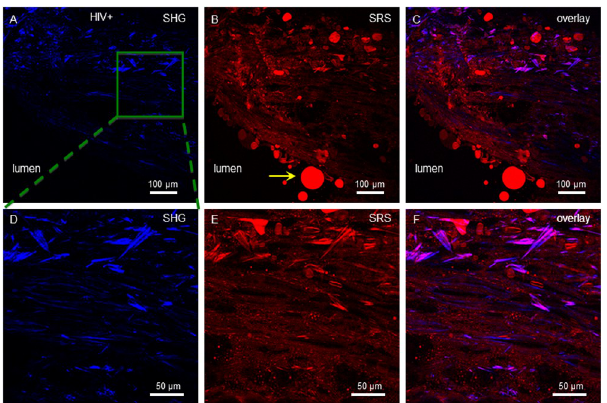
Fig 6. Lipid rich plaque from HIV + coronary artery showing needle CCs. SHG (A), SRS (B) and overlay (C) images of a lipid rich plaque. Panels (D), (E) and (F) show the same plaque at higher magnification, corresponding to the area enclosed by the green box in (A). SRS images were recorded at 2845 cm -1 . Magenta indicates regions of high overlap in the overlay images. Vessel lumen of the left descending artery and magnification scales are indicated, and yellow arrow in panel B indicates fat droplet in vessel lumen derived from extravascular adipose